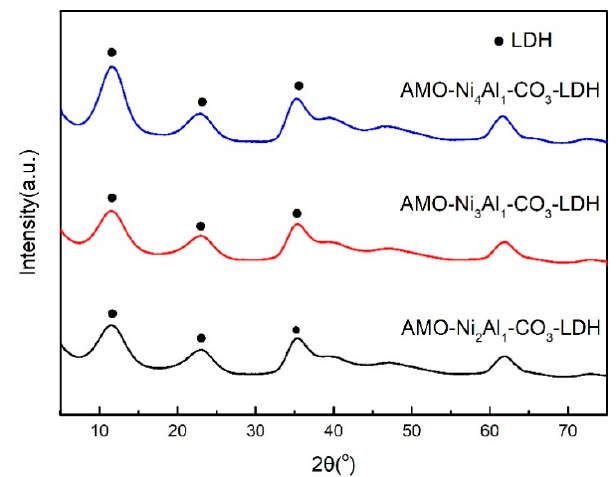
Figure 6. The powder XRD patterns of LDHs of different Ni/Al atom ratios (2:1, 3:1 and 4:1).